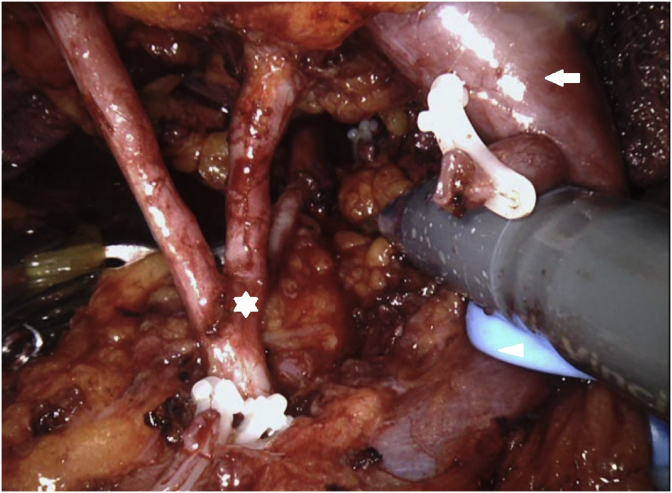
Mobilization of the right hilar vessels (three-branched renal artery; white star, renal vein; white arrow, vessel loop; white arrowhead).